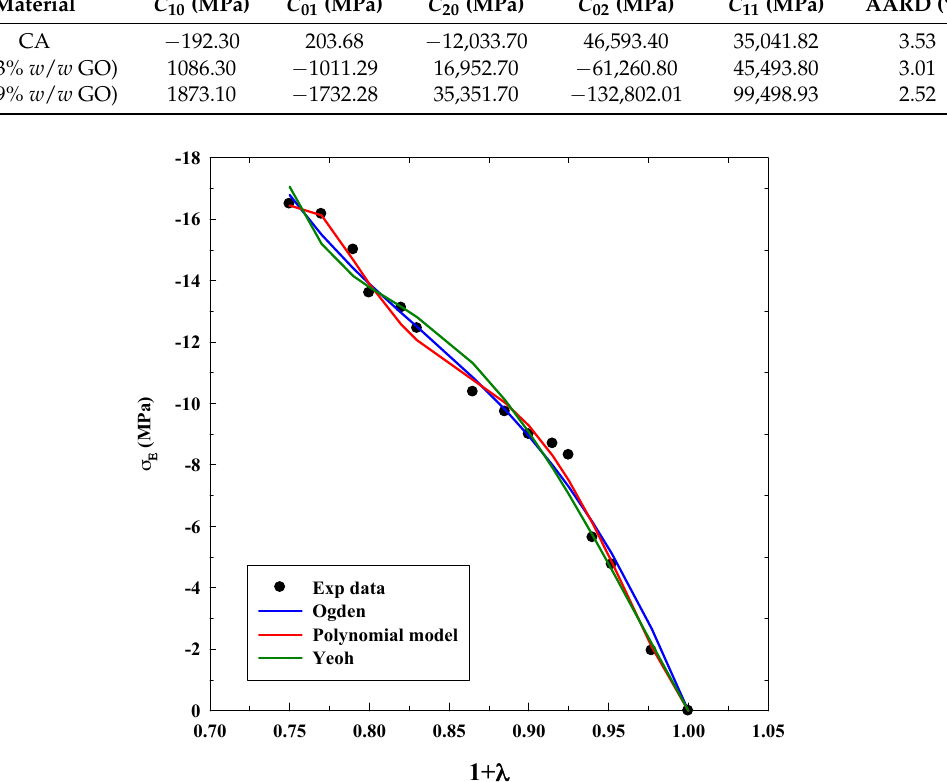
Figure 9. Fitting of compression tests for the system CA without GO using different models.